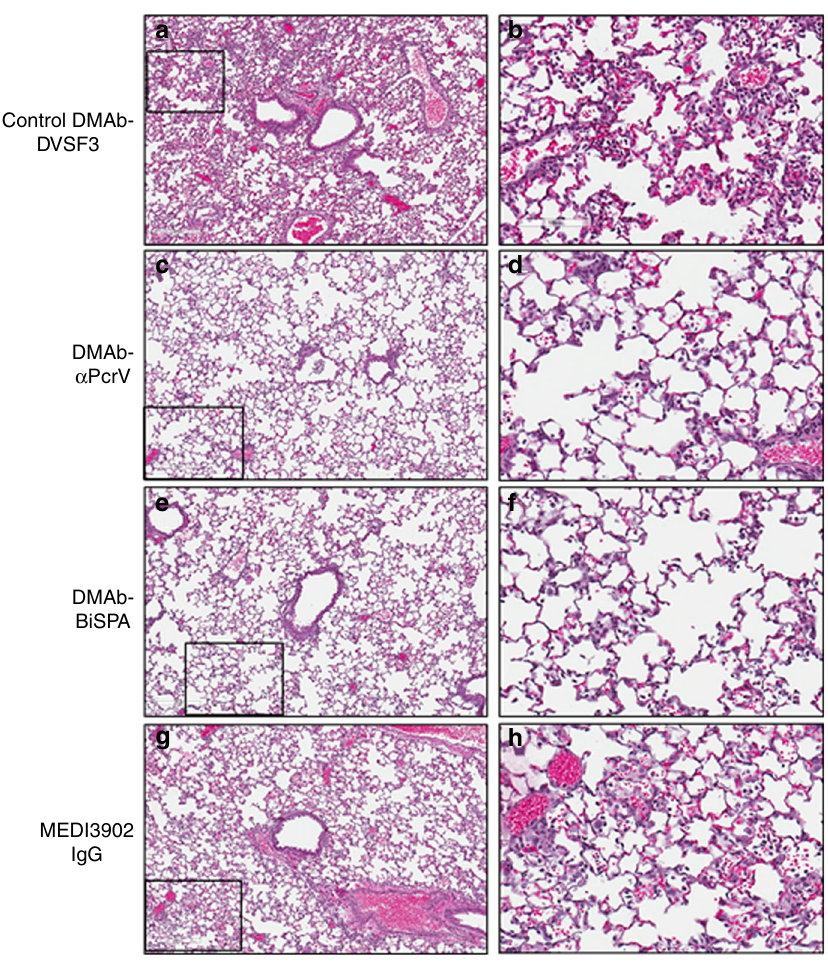
Fig. 6 Histology of acute pneumonia at 48 h post infection with P. aeruginosa . a Post-EP with DMAb-DVSF3 showing coalescing areas of marked alveolar in fi ltrate and hemorrhage (10 × magni fi cation). b Alveoli have marked neutrophilic in fi ltrates, hemorrhage, and areas of necrosis ( inset ). c Mild pneumonia and occasional bronchiolar debris with DMAb- α PcrV (10 × magni fi cation). d Alveolar in fi ltrates comprises mixed neutrophilic and macrophage populations ( inset ). e DMAb-BiSPA group with mild alveolitis (10 × magni fi cation). f Primarily neutrophilic in fi ltrates and mild hemorrhage in alveolar spaces ( inset ). g MEDI3902 IgG control demonstrates moderate alveolitis (10 × magni fi cation). h Alveolar spaces contain neutrophils admixed with cellular debris and hemorrhage ( inset ). Representative data from fi ve